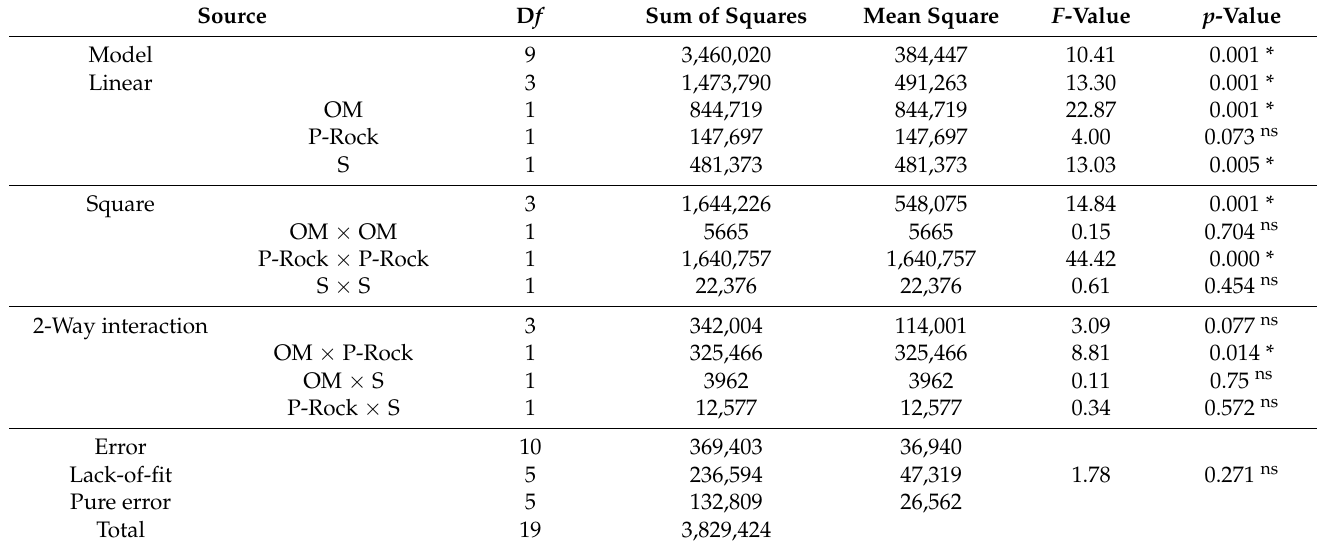
P-Rock, phosphate rock; OM, organic matter; S, sulfur; *, statistically significant; ns, not statistically significant. R 2 = 90.35%, Adj- R 2 =